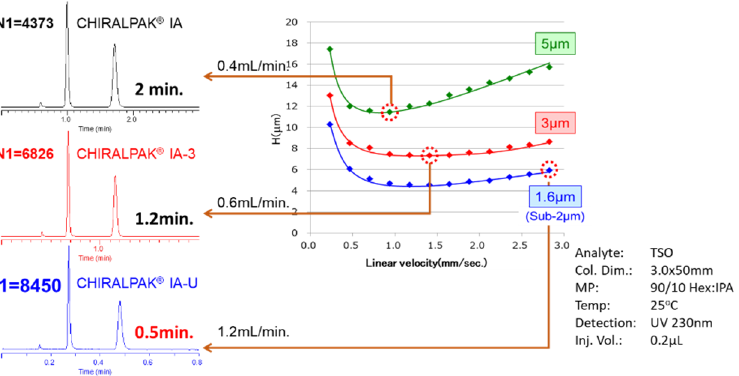
Figure 1. Van Deemter plot for varying particle sizes of Chiralpak IA immobilized polysaccharide CSP.